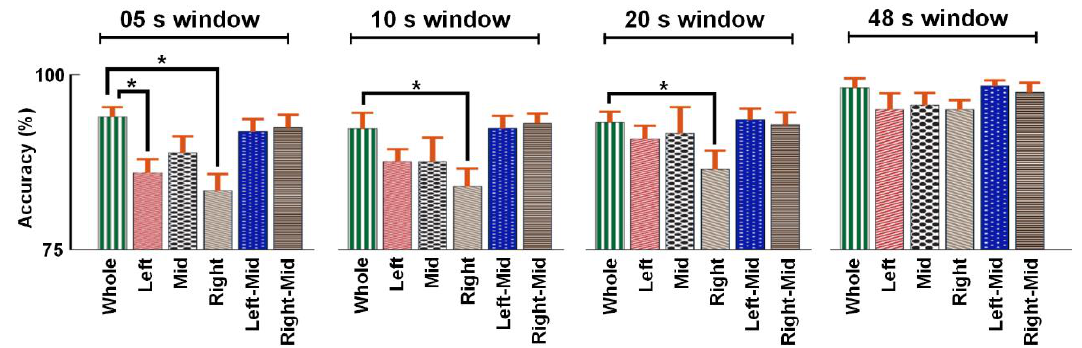
Figure 4. Mean accuracy of classifications across various location for different segmentation window lengths. The standard errors of the mean classification accuracies are presented by the error bars. The four classification accuracy means whose differences are statistically significant are highlighted for significance with stars.